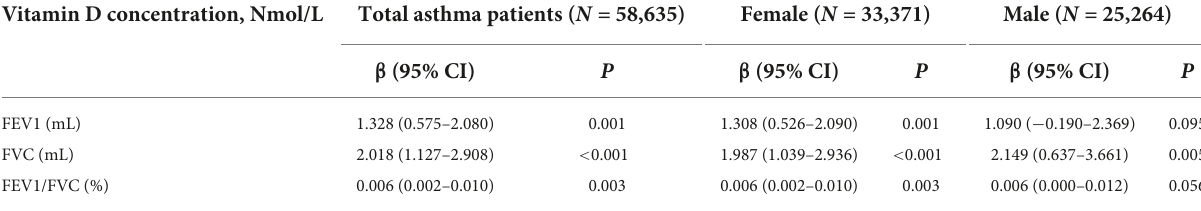
TABLE 3 Multivariable analysis of vitamin D concentrations and lung function measures among asthmatic patients. Vitamin D concentration,